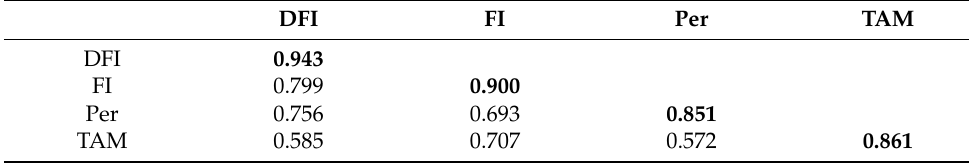
Table 6. Discriminant validity for